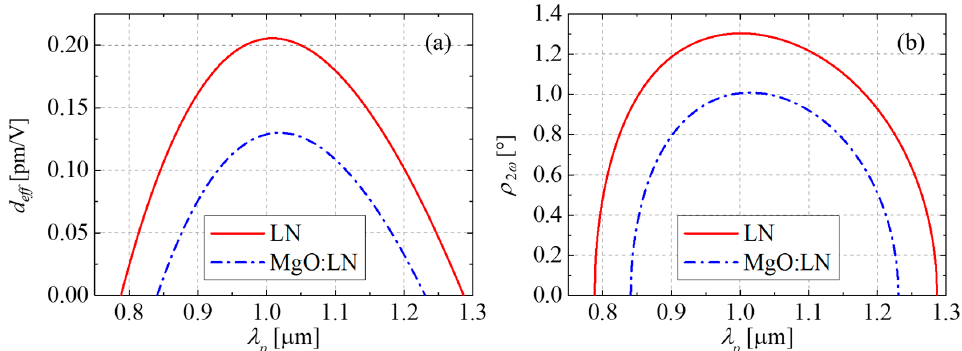
Figure 5. ( a ) Effective nonlinear optic coefficients ( d eff ) under Type II EPM, numerically calculated for the two kinds of non-poled LNs: LN and 5-mol% MgO:LN; ( b ) the walk-off angle ρ 2 ω , calculated for the PM solution set of λ p and θ . Now we investigate the temperature behaviors of the Type II EPM properties of LNs.